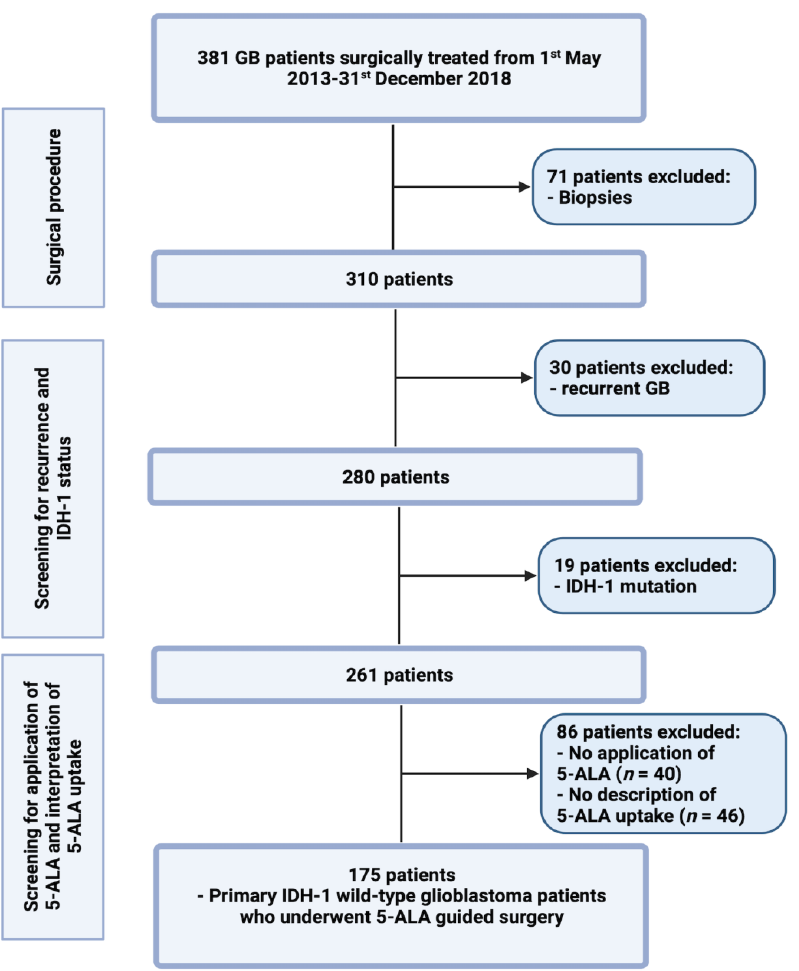
Figure 1. Flow chart illustrating the selection process of consecutive meningioma patients between 1 May 2013 and 1 December 2018.